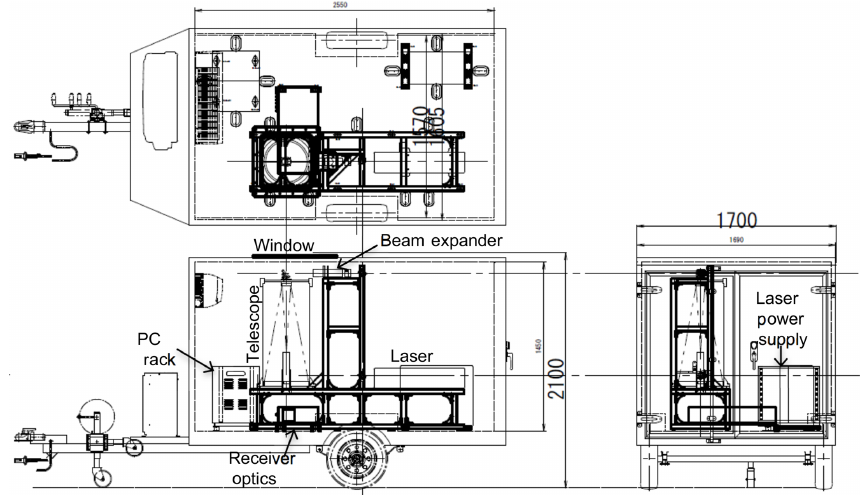
Figure 2. Layout of the mobile Raman lidar system in its trailer. Dimensions are in millimeters.